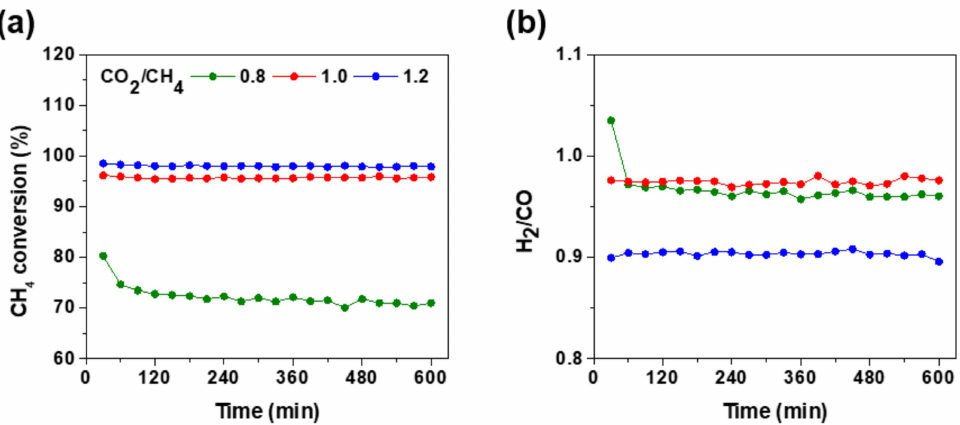
Figure 4. Time on stream results of the dry-reforming reaction with Ni/Al 2 O 3 catalyst: ( a ) CH 4 conversion, ( b ) H 2 /CO ratio; T = 850 ◦ C, WHSV = 60 L/g · h − 1